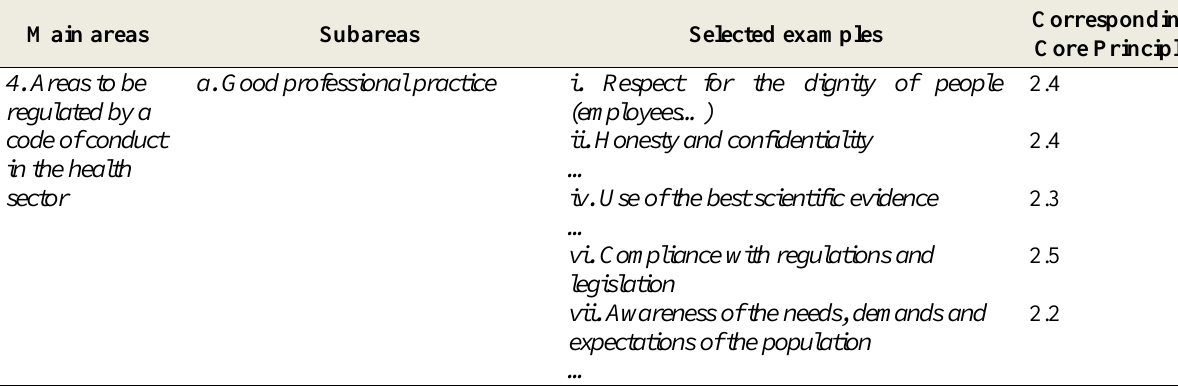
Table 2. General framework for codes of conduct in the health sector of the Council of